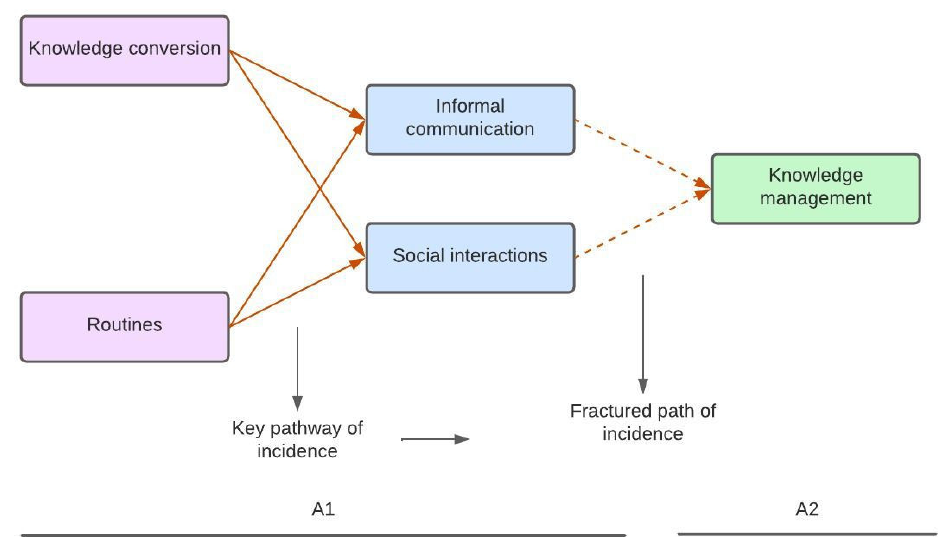
Figure 6. Second-order incidents for knowledge management. Source: Own elaboration.